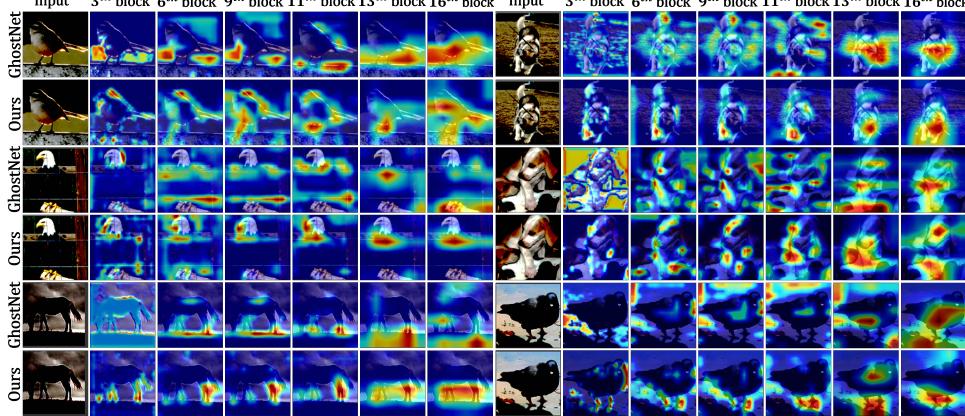
Figure 3. Visualization of features extracted from GhostNet and GhostNeXt on